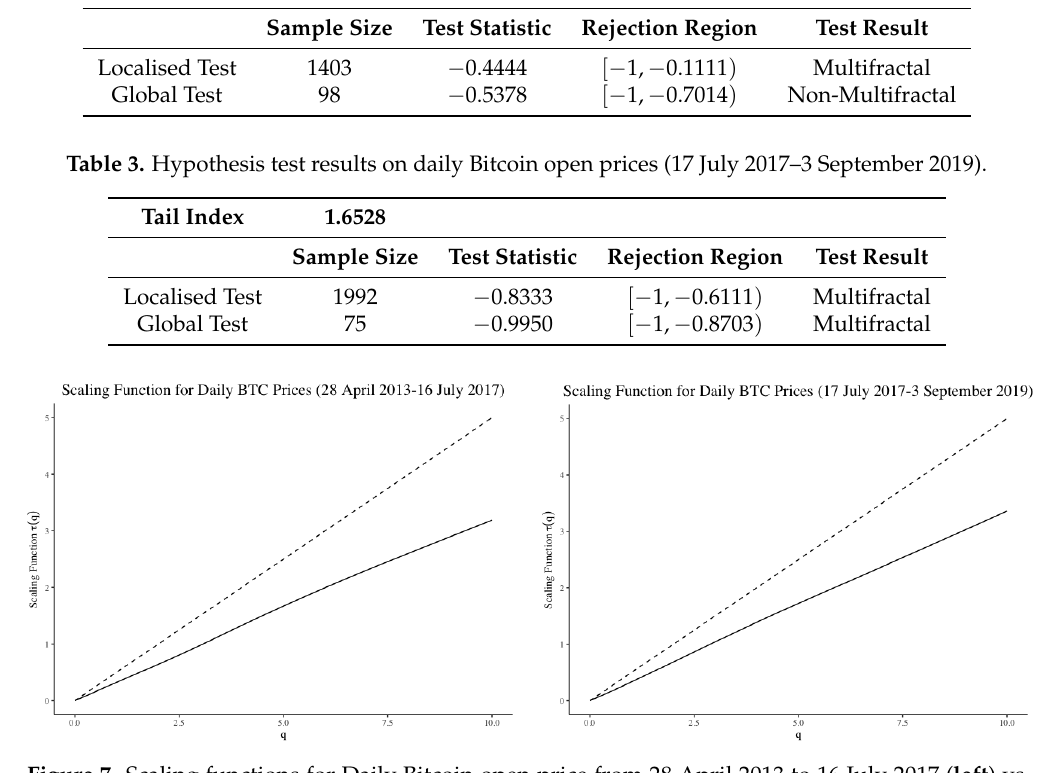
Figure 7. Scaling functions for Daily Bitcoin open price from 28 April 2013 to 16 July 2017 ( left ) vs. from 17 July 2017 to 3 September 2019 ( right